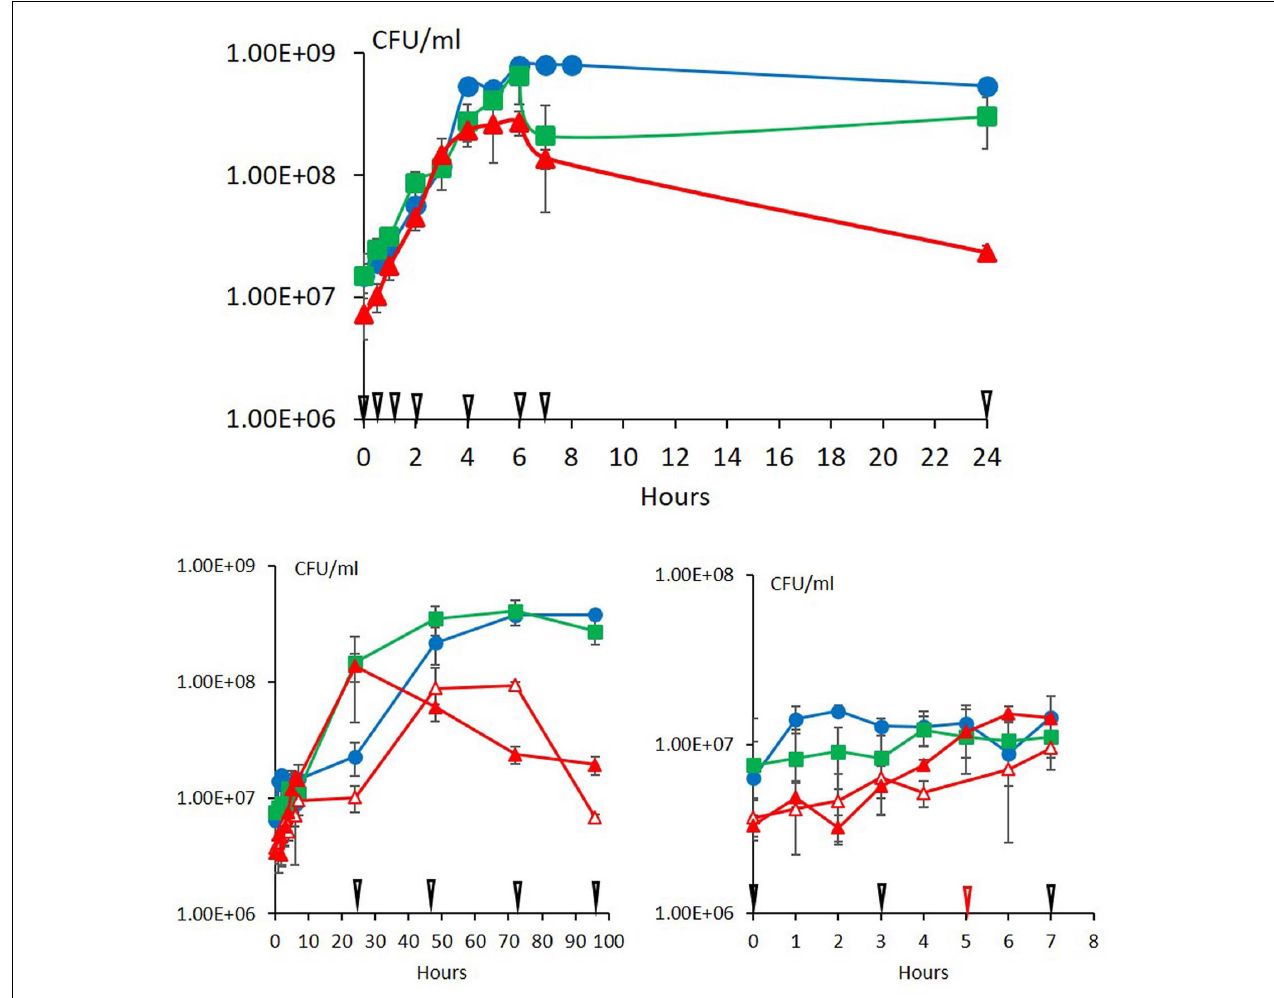
FIGURE 1 | Growth of the three strains of B. cereus ATCC 10876 (green squares), ATCC 14579 T (blue circles), and MM3 (red triangles) at warm (upper panel) and cold (lower panels) temperatures. Warm temperature was 30 ◦ C for all strains. Cold temperatures were 12 ◦ C (close symbols) and 10 ◦ C for MM3 only (open symbols). Arrows indicate growth times at which cultures were sampled for fatty acid analysis (black: 0, 0.5, 1, 2, 4, 6, 7, and 24 h at 30 ◦ C, 0, 3, 7, 24, 48, 72, and 96 h at 10 and 12 ◦ C) and for MM3 at 10 ◦ C only (red: 5 h). At cold temperatures, growth during the first 7 h is detailed in the lower right-hand panel. Error bars represent standard deviation ( n =